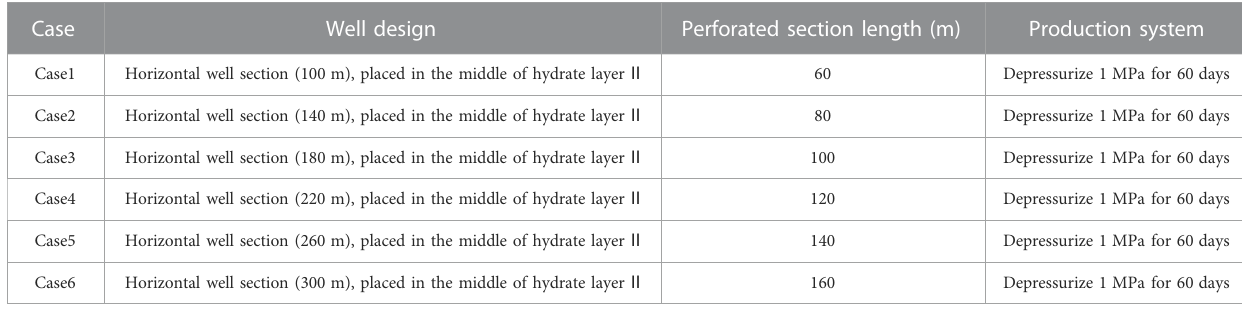
TABLE 4 Optimized the horizontal well section length.